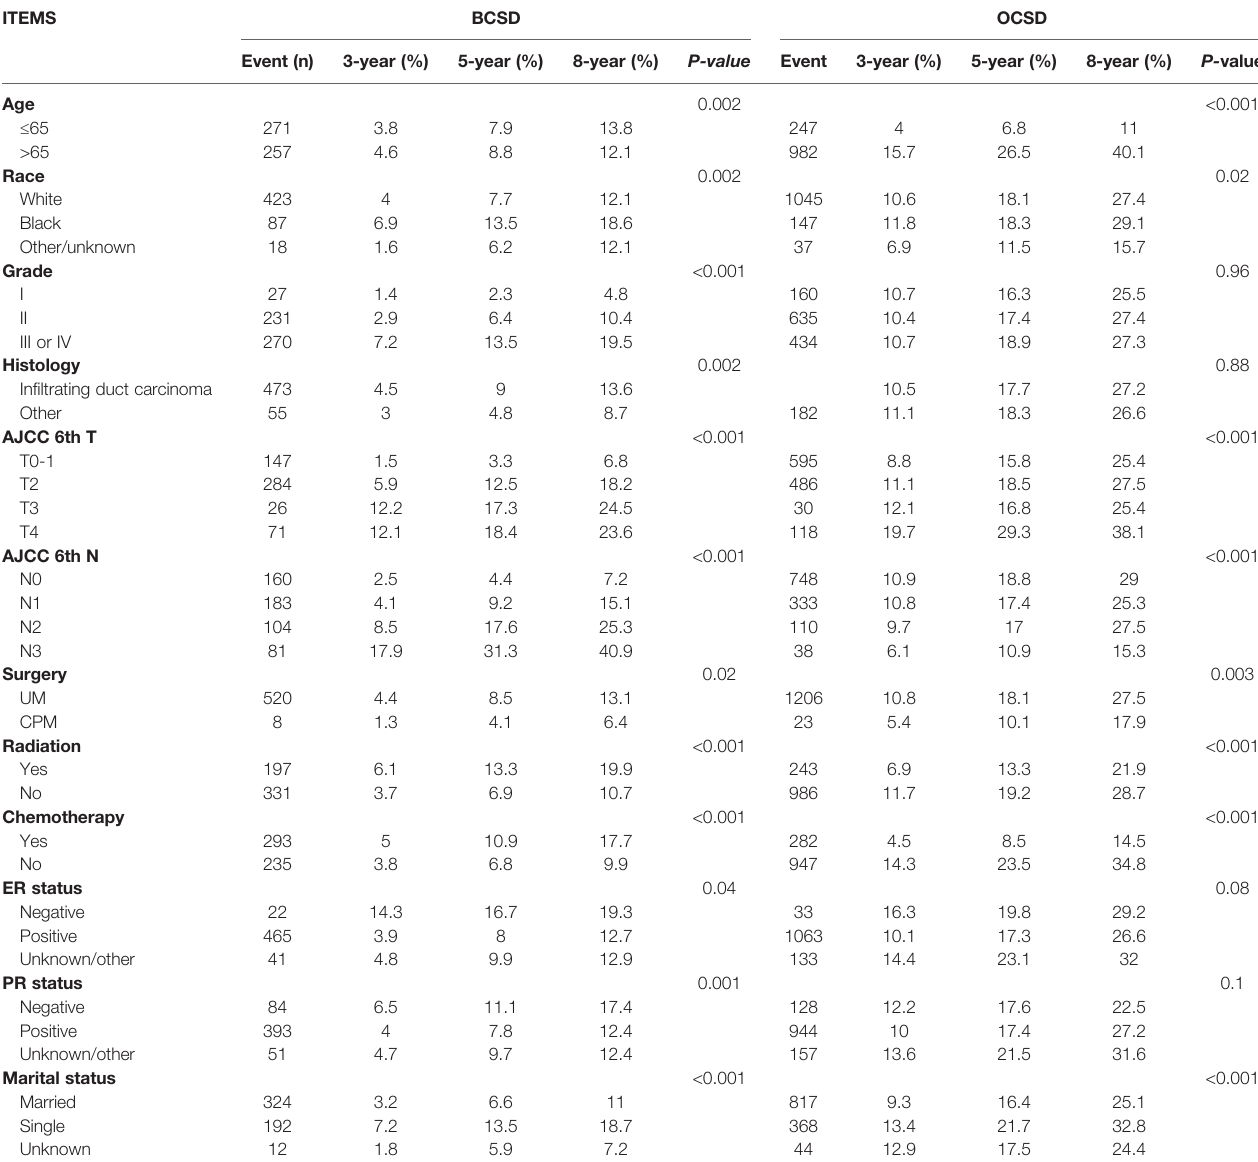
TABLE 3 | Univariate competing risk model analysis of death causes in MaBC patients. ITEMS BCSD OCSD Event (n)